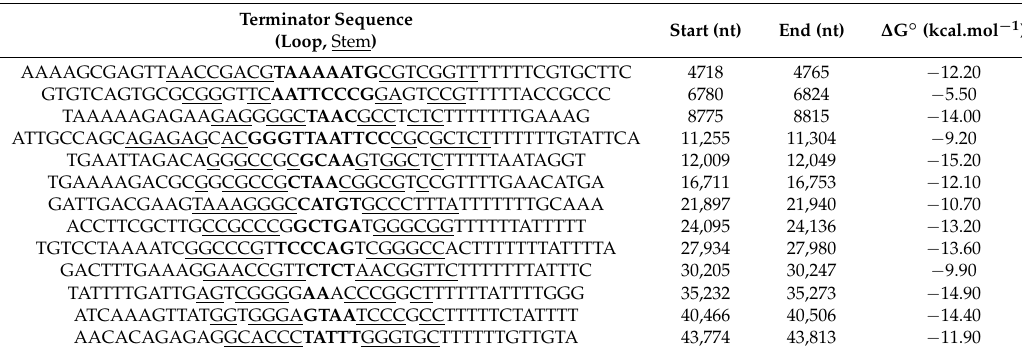
Table 2. Rho-independent transcriptional terminators of SPP1. The terminators were identified as described in Material and Methods (see Section 2). Putative stem (underlined) and loop (bold) regions are highlighted. The coordinates of the sequence presented are shown (nt—nucleotide). The ∆ G ◦ of the RNA stem loop is shown on the right